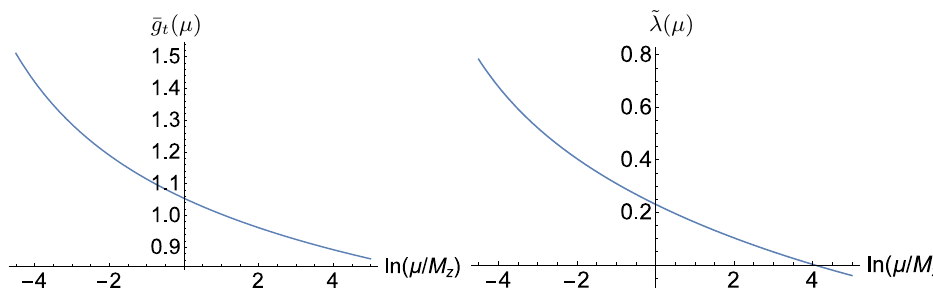
Figure 2 . Using experimentally measured SM quantities (including m t and m values, we uniquely solve the RG equations for the composite Higgs-boson model [28], we find [20, 51] the effective top-quark Yukawa coupling ¯ g t ( µ ) (left) and effective Higgs quartic coupling ˜ λ ( µ ) (right) in the range 1 . 0 GeV . µ . 13 . 5 TeV. Note that ˜ λ (